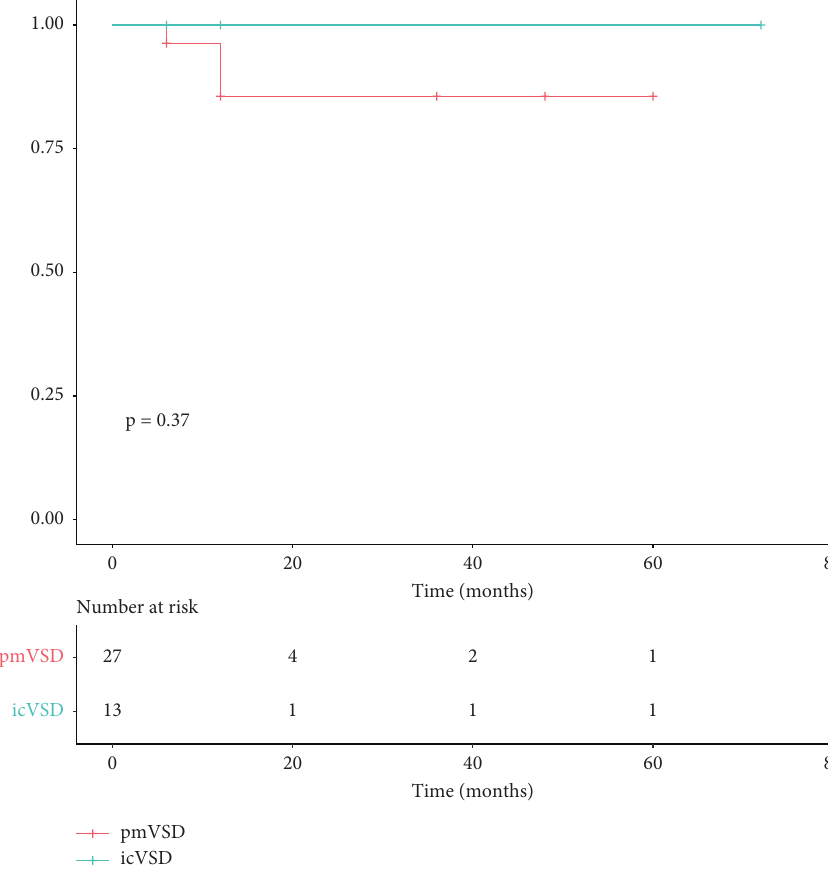
Figure 3: Kaplan–Meier curve depicting freedom from complications across